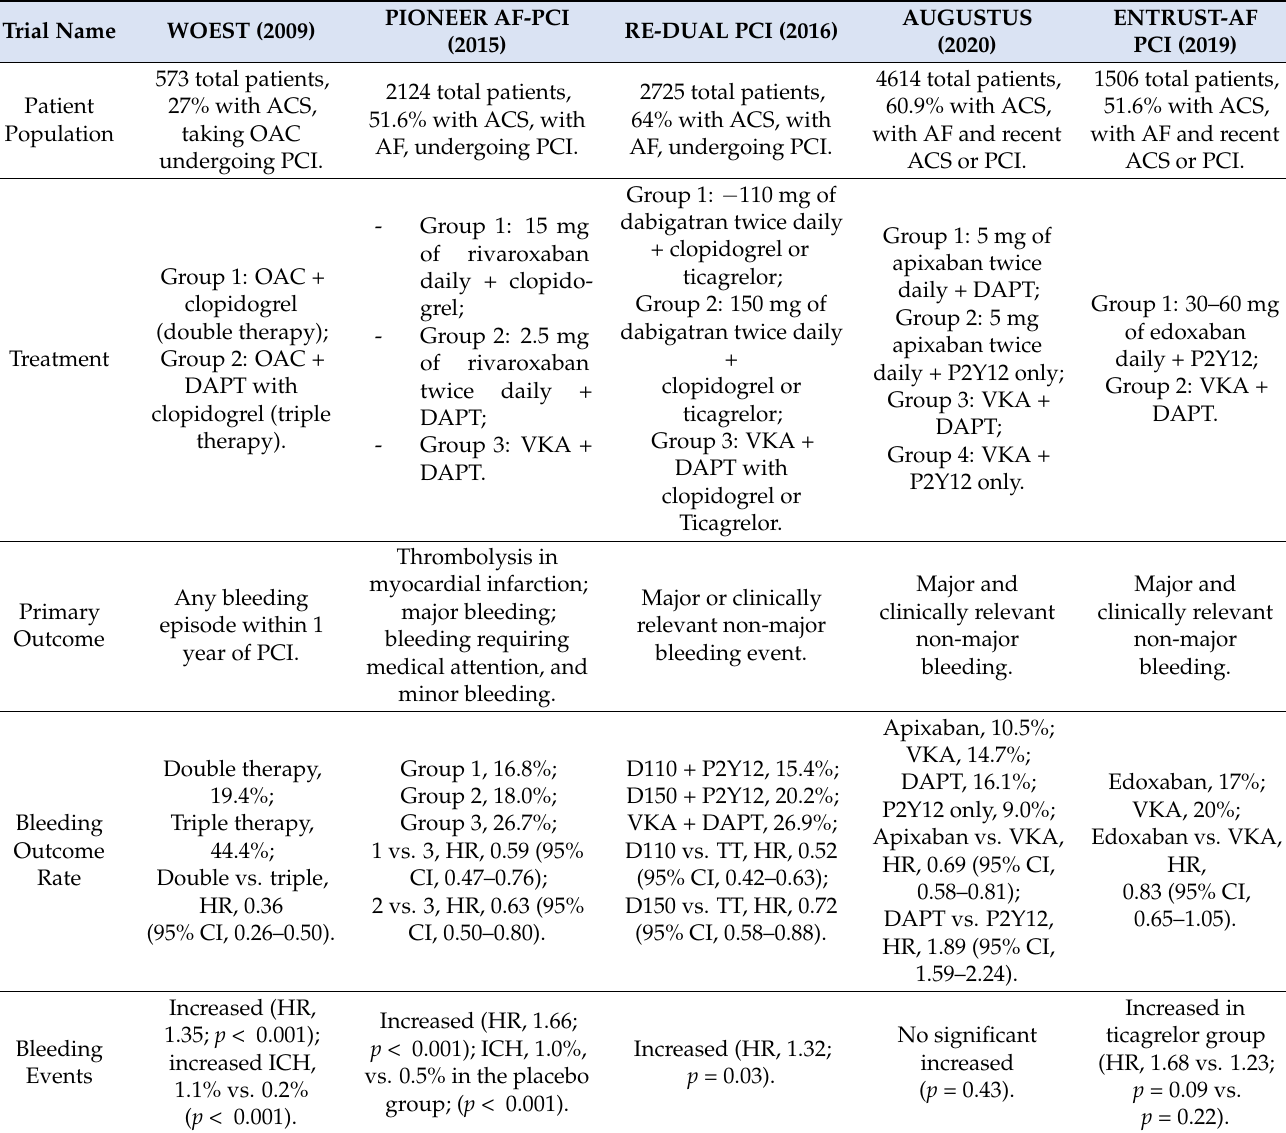
Table 2. Trials of combined antithrombotic drugs in atrial fibrillation (AF) and coronary artery disease